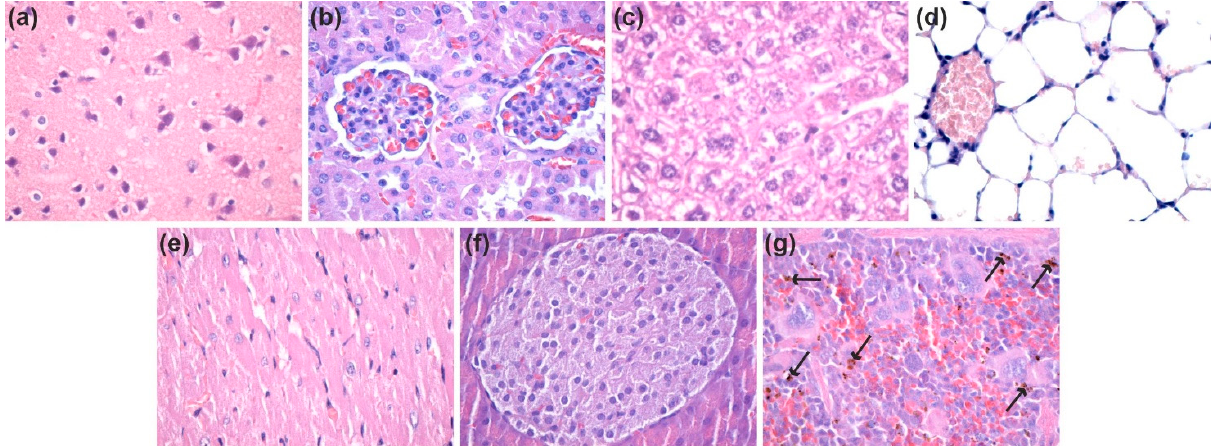
Figure 16. Micrographs of cross-sections through the mice internal organs treated with ZnO NPs after seven days (HE staining, ×400): ( a ) Brain; ( b ) Kidney; ( c ) Liver; ( d ) Lung; ( e ) Myocardium; ( f ) Pancreas; ( g ) Spleen (see arrows for ZnO@LiN NPs). HE: Hematoxylin–Eosin. (×100).